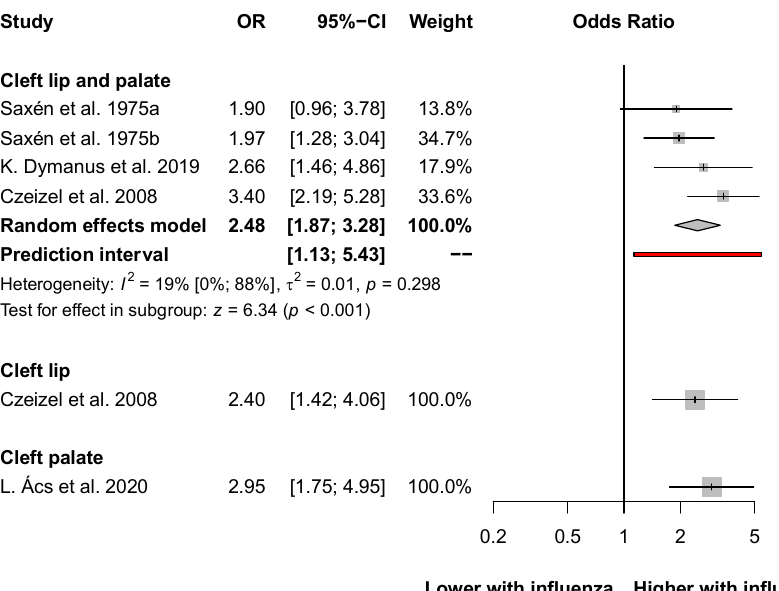
Figure 4. The odds of developing oral clefts after influenza infection in the first trimester